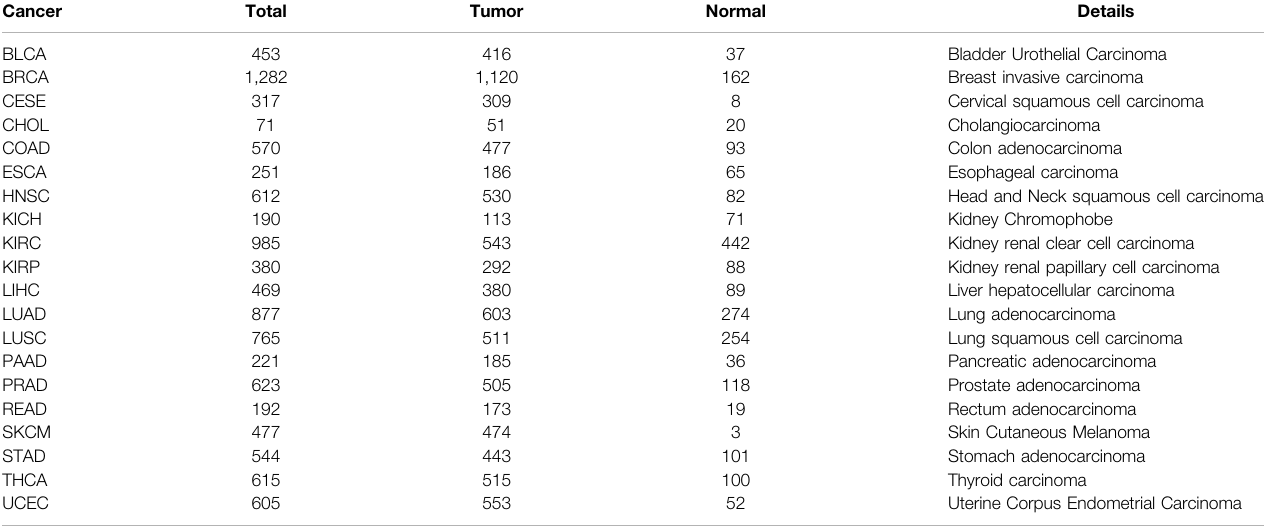
TABLE 1 | Datasets of 20 types of cancer downloaded from TCGA.